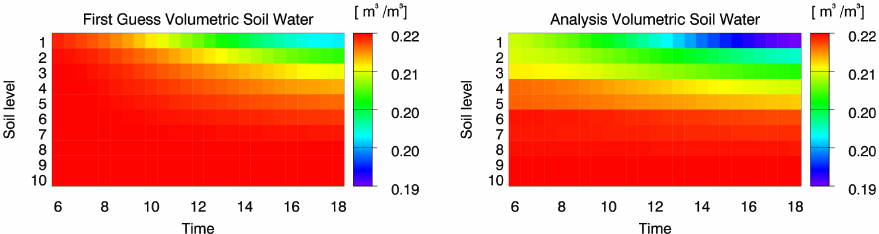
Figure 4. Time development of soil moisture profile: CLM forecast without assimilation (background run, left panel) and analysis (right